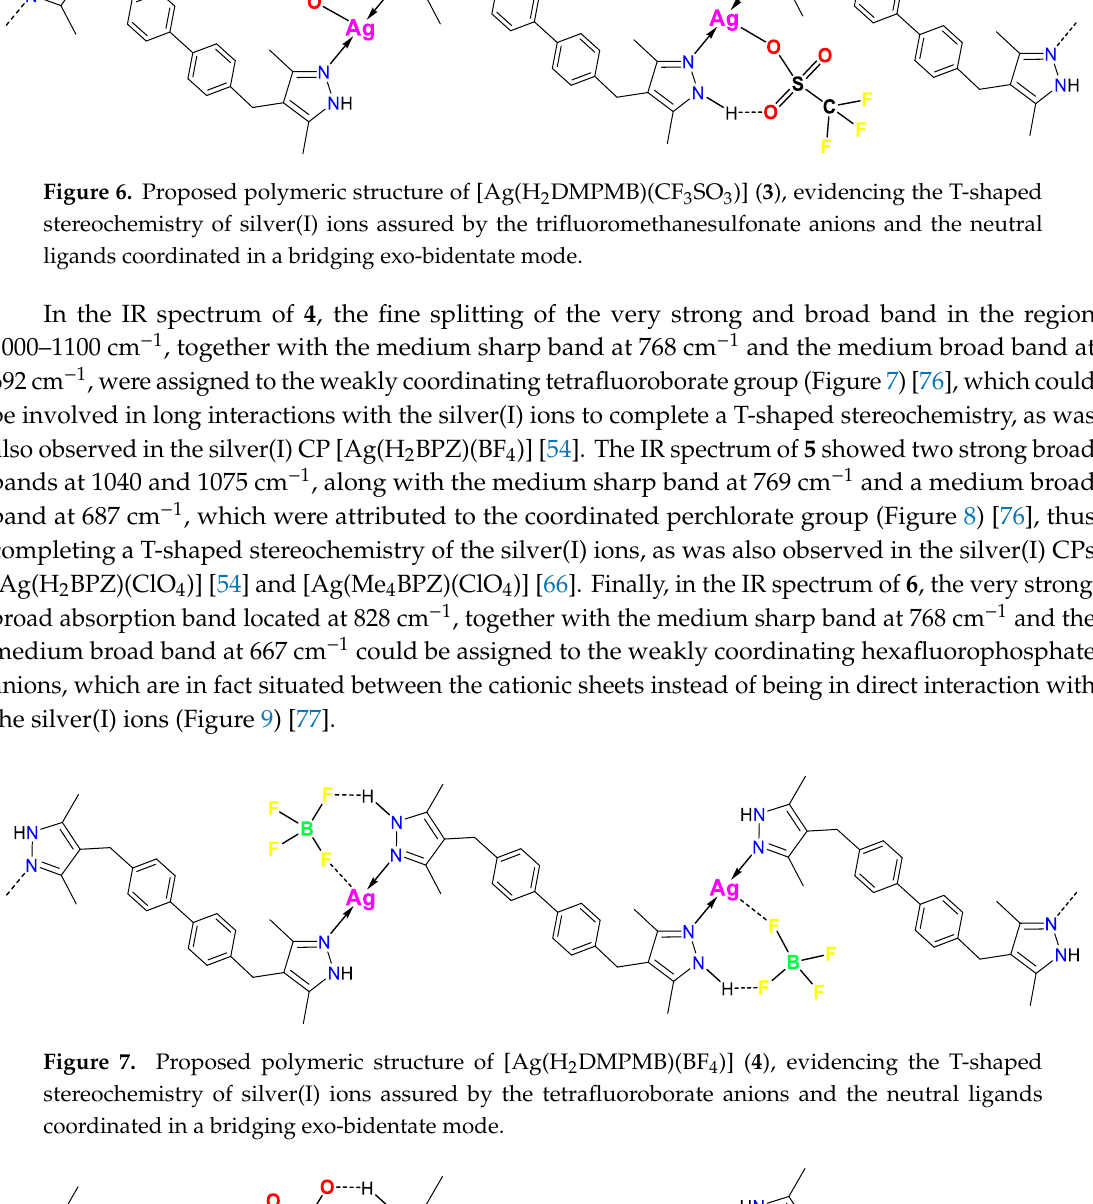
Figure 5. Proposed polymeric structure of [Ag(H 2 DMPMB)(CF 3 CO 2 )] ( 2 ), evidencing the T-shaped stereochemistry of silver(I) ions assured by the trifluoroacetate anions and the neutral ligands coordinated in a bridging exo-bidentate mode.